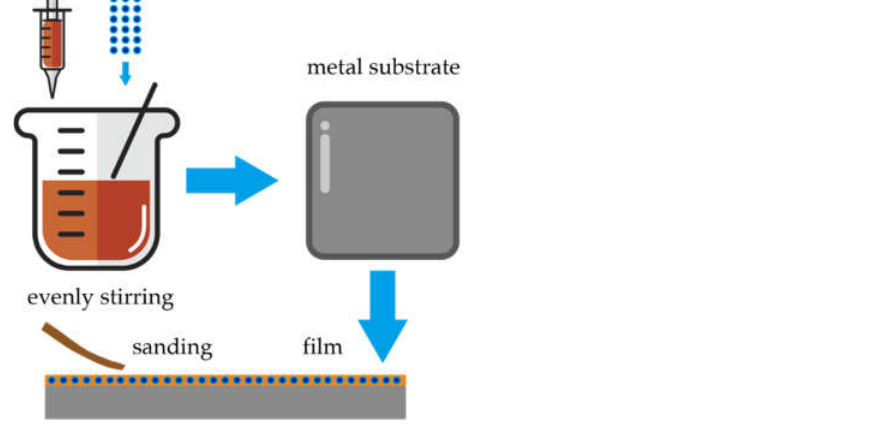
Figure 1. Schemes following the film.